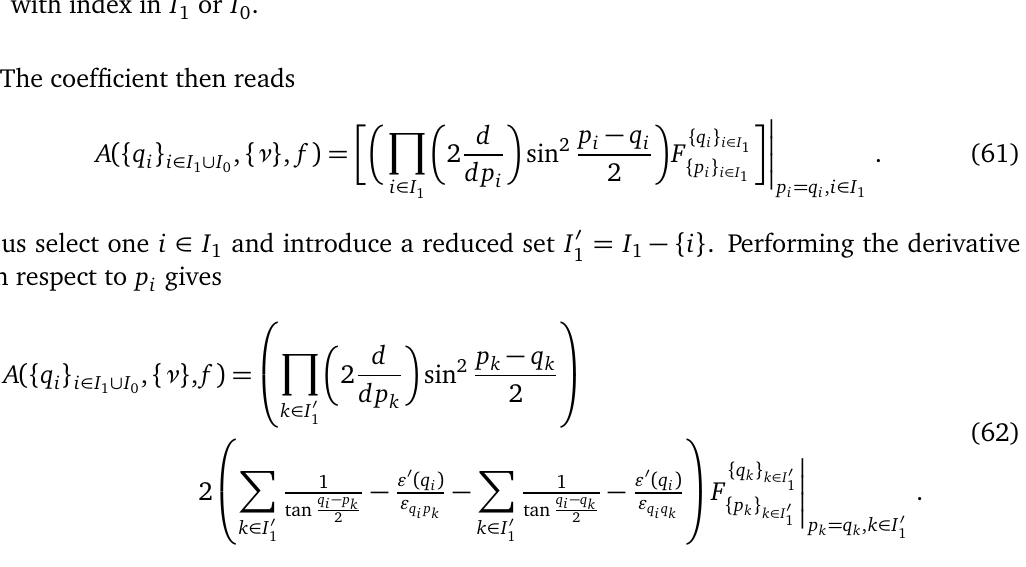
Figure 5: Sketch of the two functions f after one step of recursion. In red are in- dicated the p ’s, in blue the q ’s that play the role of the p ’s after the first step of the recursion, that are those with index in I or I . The ’new’ q ’s on the last row are those 1 2 with index in I or I 1 0